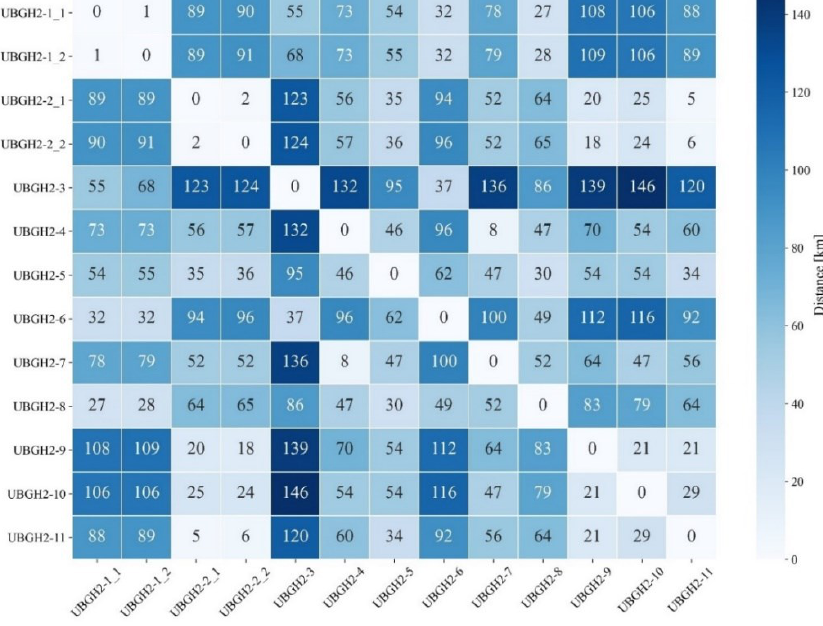
Figure 2. Distance matrix between 13 wellbores in the UBGH2 field.